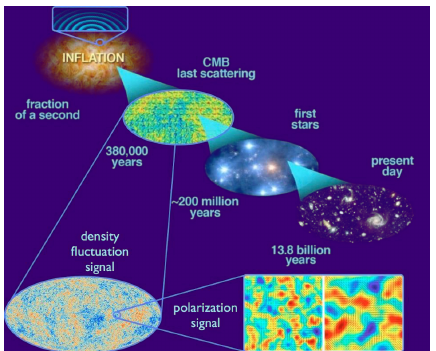
Figure 15. Inflationary universe.